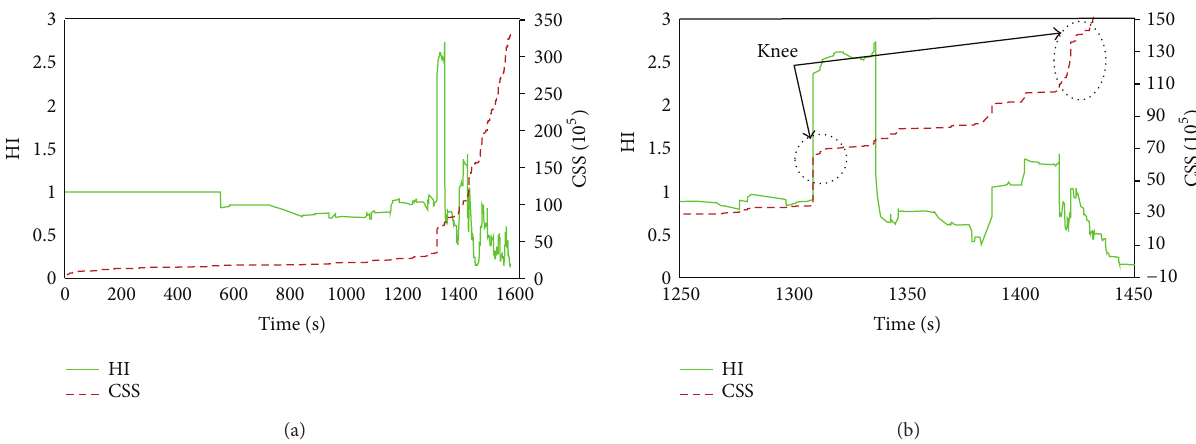
Figure 8: AE signal strength analysis for DC specimen. (a) Historic index as a function of time. The plot of the cumulative signal is superimposed. (b) Magnified portion of plot (a).